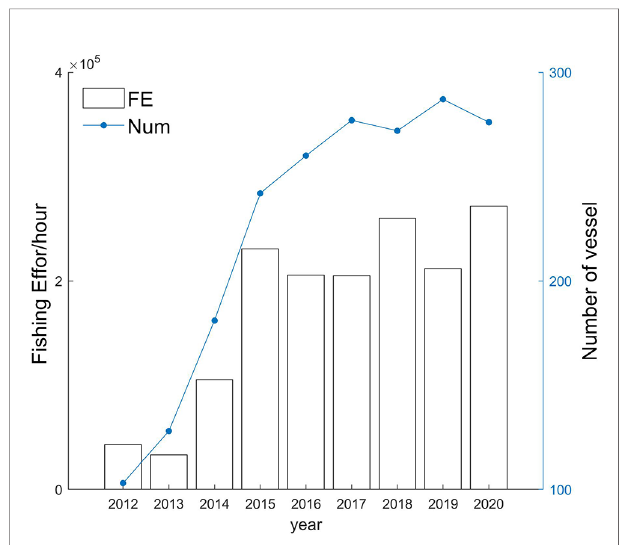
FIGURE 1 | The fi shing effort and number of fi shing vessels during 2012-2020.(FE, Fishing effort; Num, Number of